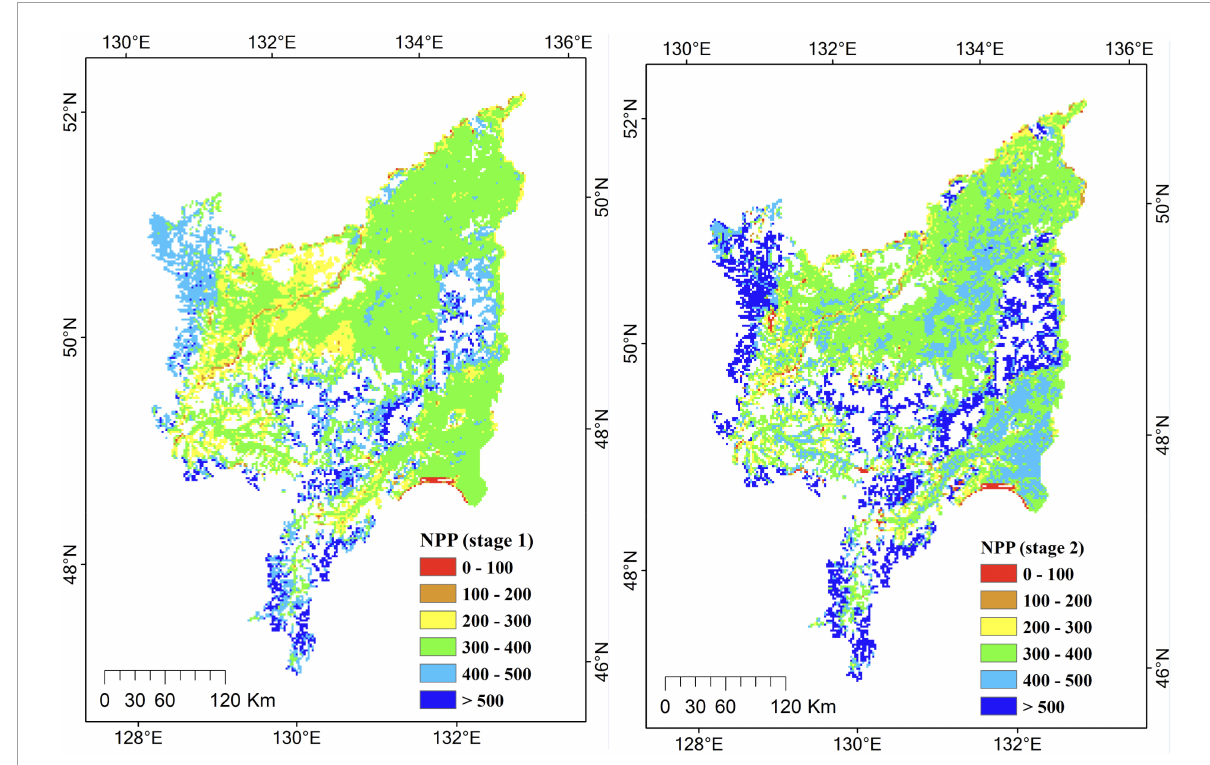
FIGURE3 Spatial changes of net primary productivity since 1954 in the marsh area of the Sanjiang Plain (unit: gC/m − 2 /yr).